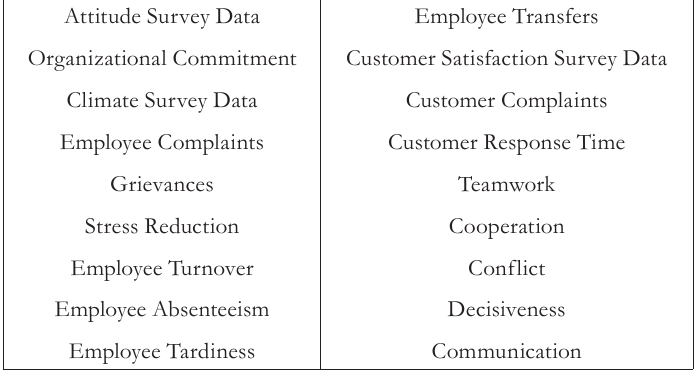
Tab. 1 – Typical Intangible Variables Linked with Diversity. Source: Hubbard, 2011,